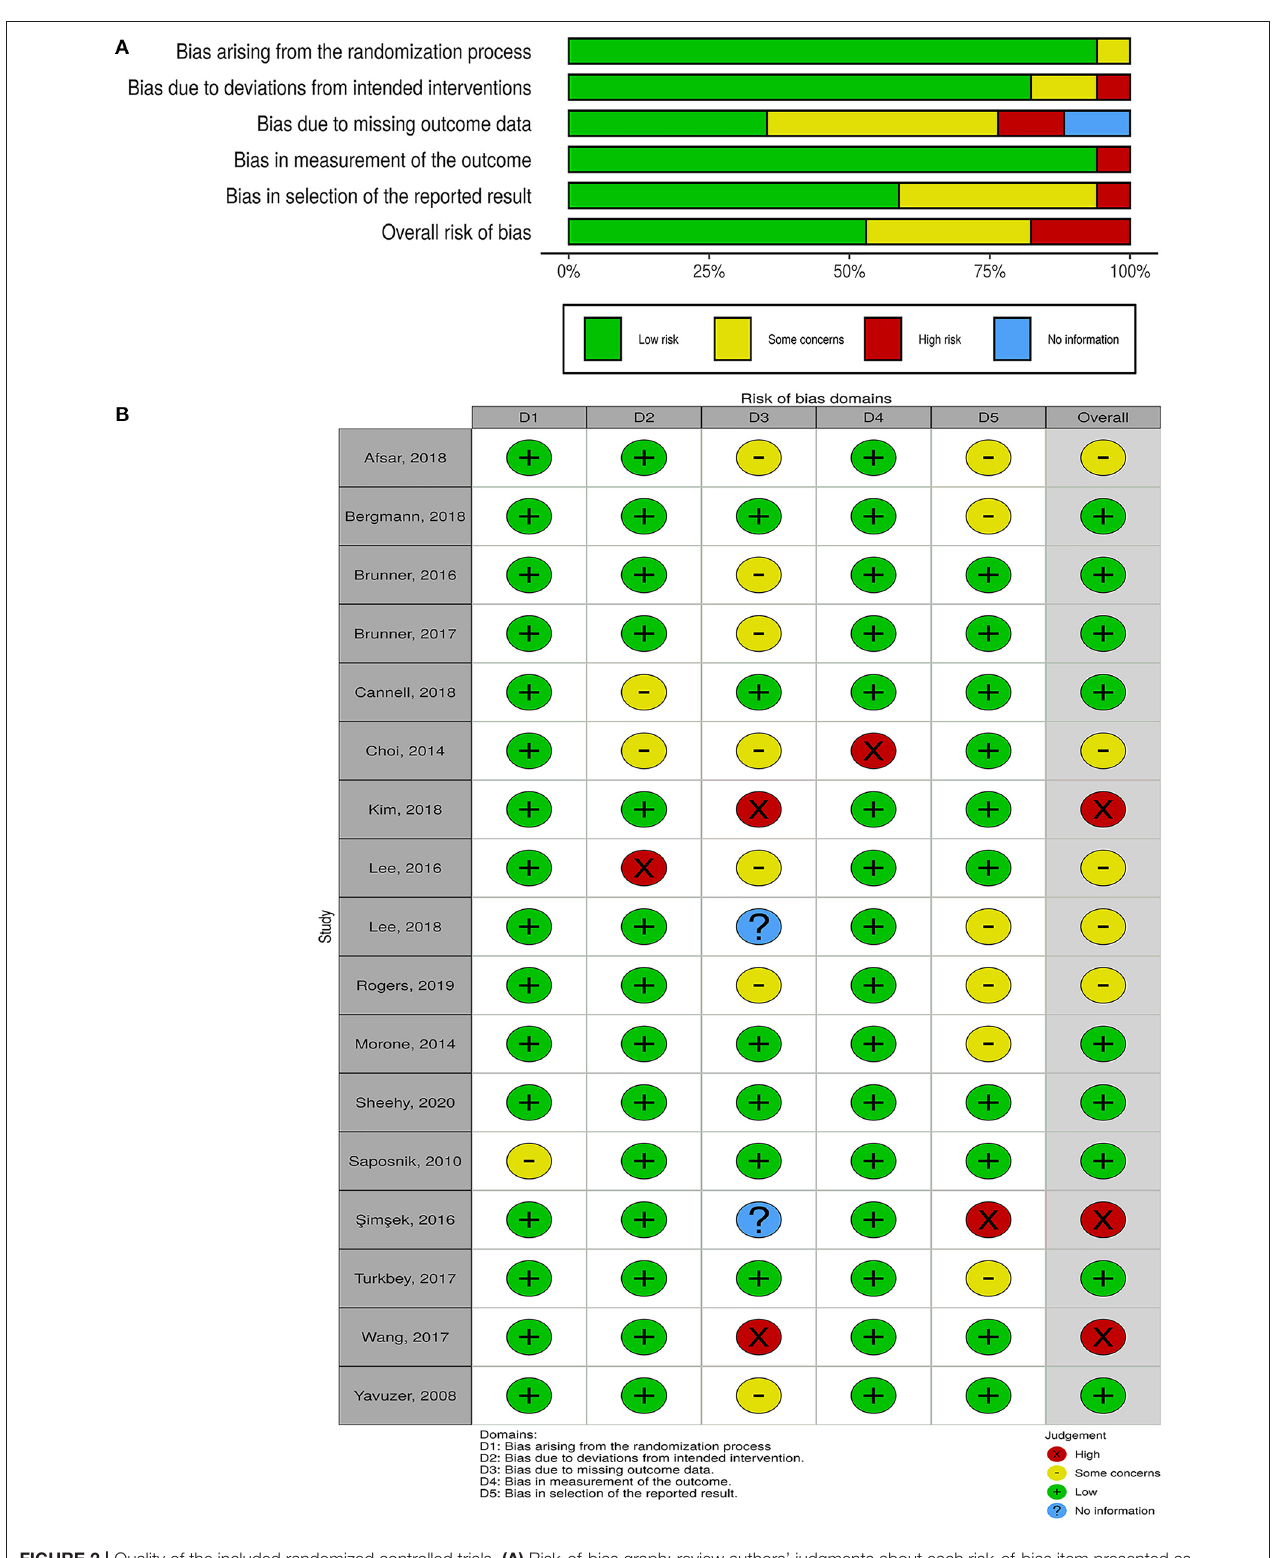
FIGURE 2 | Quality of the included randomized controlled trials. (A) Risk-of-bias graph: review authors’ judgments about each risk-of-bias item presented as percentages across all included studies. (B) Risk-of-bias summary: review authors’ judgments about each risk-of-bias item for each included study.